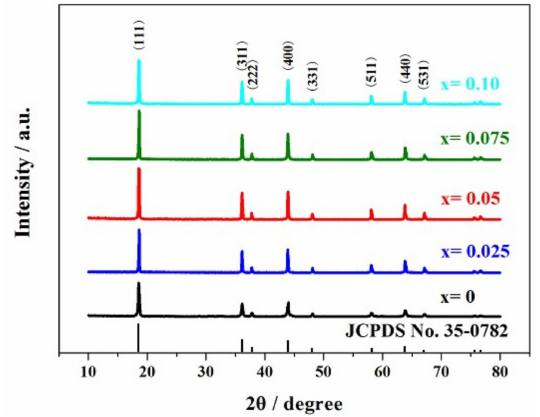
Figure 1. XRD patterns of the LiSi x Mn 2 − x O 4 (x = 0, 0.025, 0.05, 0.075 and 0.10) samples.